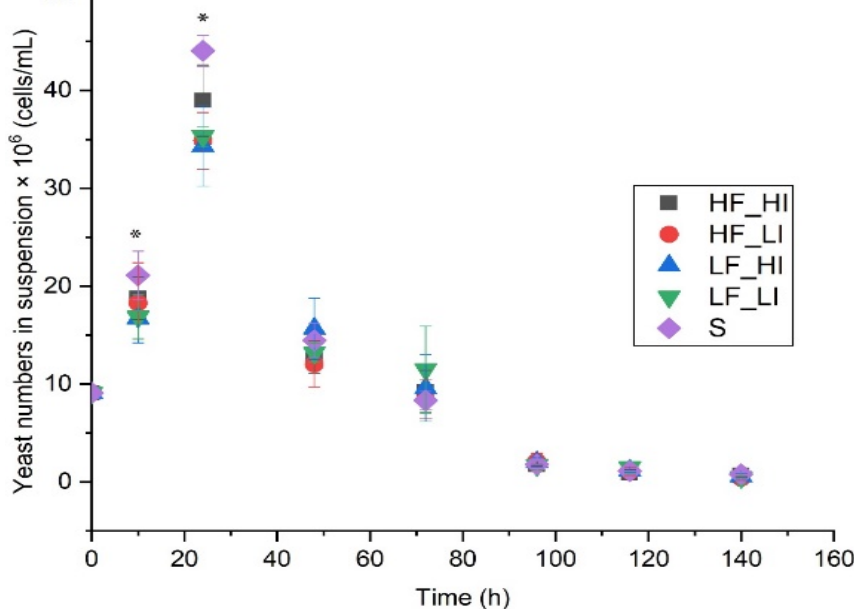
Figure 1. Viable yeast cells in suspension versus fermentation time for five sound treatments. Low-frequency and low intensity (LF_LI); low-frequency and high-intensity (LF_HI); high-frequency and low-intensity (HF_LI); high-frequency and high-intensity (HF_HI); silence (S). *Overall significant differences in means observed at 10 and 24 h (Table S1 Supplementary Material). Data shown are means of three fermentation replicates ± standard deviation (SD).